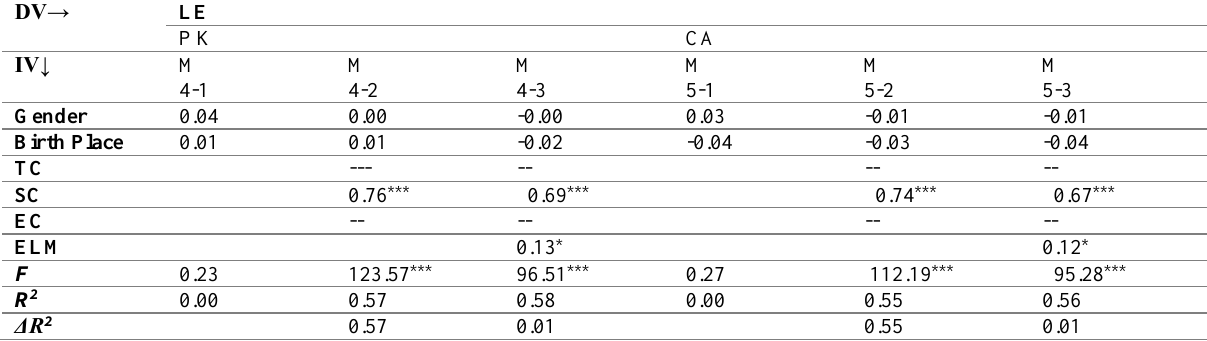
Table 4: The Mediating Effect of ELM in the Relationship between TS and